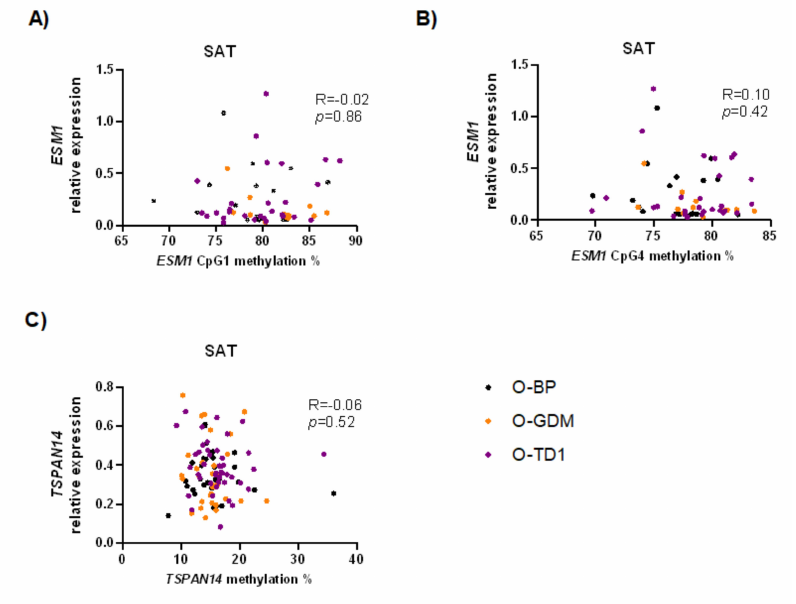
Figure 4. Correlation analysis between subcutaneous adipose tissue (SAT) gene expression and methylation level at target CpG sites of ESM1 (cg00992687/CpG1 ( A ) and cg09452568/CpG4 ( B )), and TSPAN14 (cg11411705 ( C )). R-values and p -values were calculated using a Spearman rank test. Black dots indicate O-BP, orange dots indicate O-GDM, and purple dots indicate O-T1D. O-GDM: offspring of women with GDM, O-T1D: offspring of women with T1D, O-BP: offspring of women from the background population. Table 2. Association between gene expression of ESM1 and TSPAN14 and maternal diabetes in pregnancy and pre-pregnancy